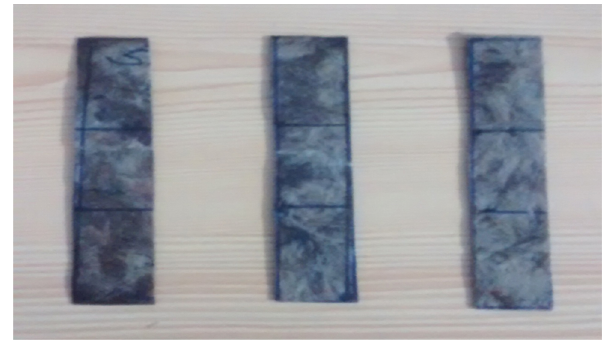
Figure 5: Tensile test